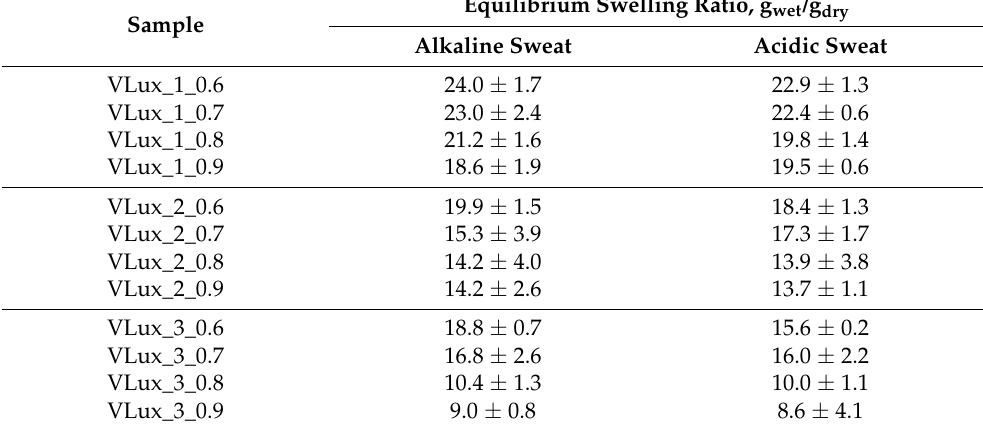
Table 7. Comparison of equilibrium swelling ratio for alkaline and acidic pH sweat depending on I NCO and water